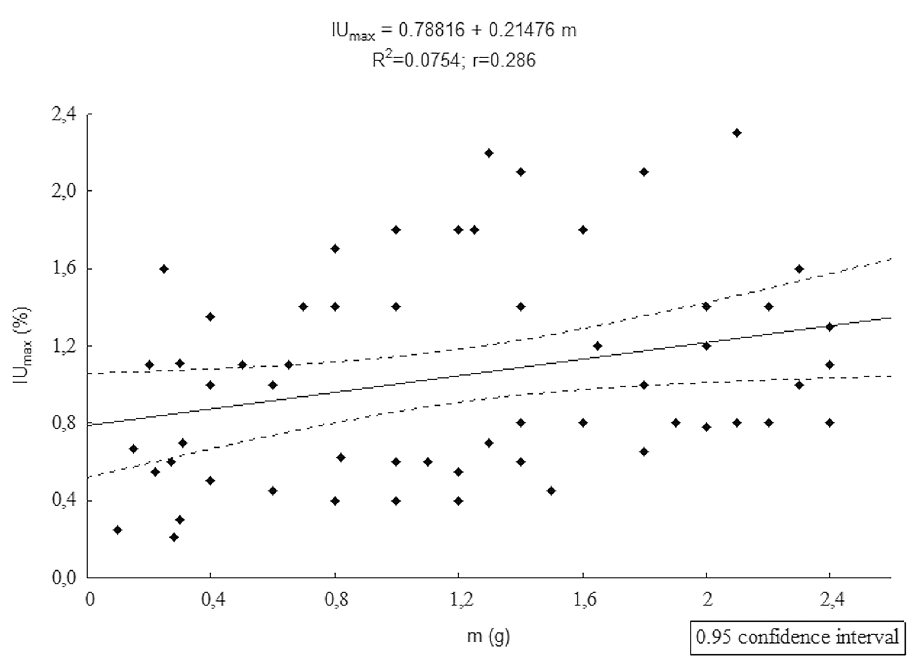
Figure 3. Dependence of parameters m and IU max